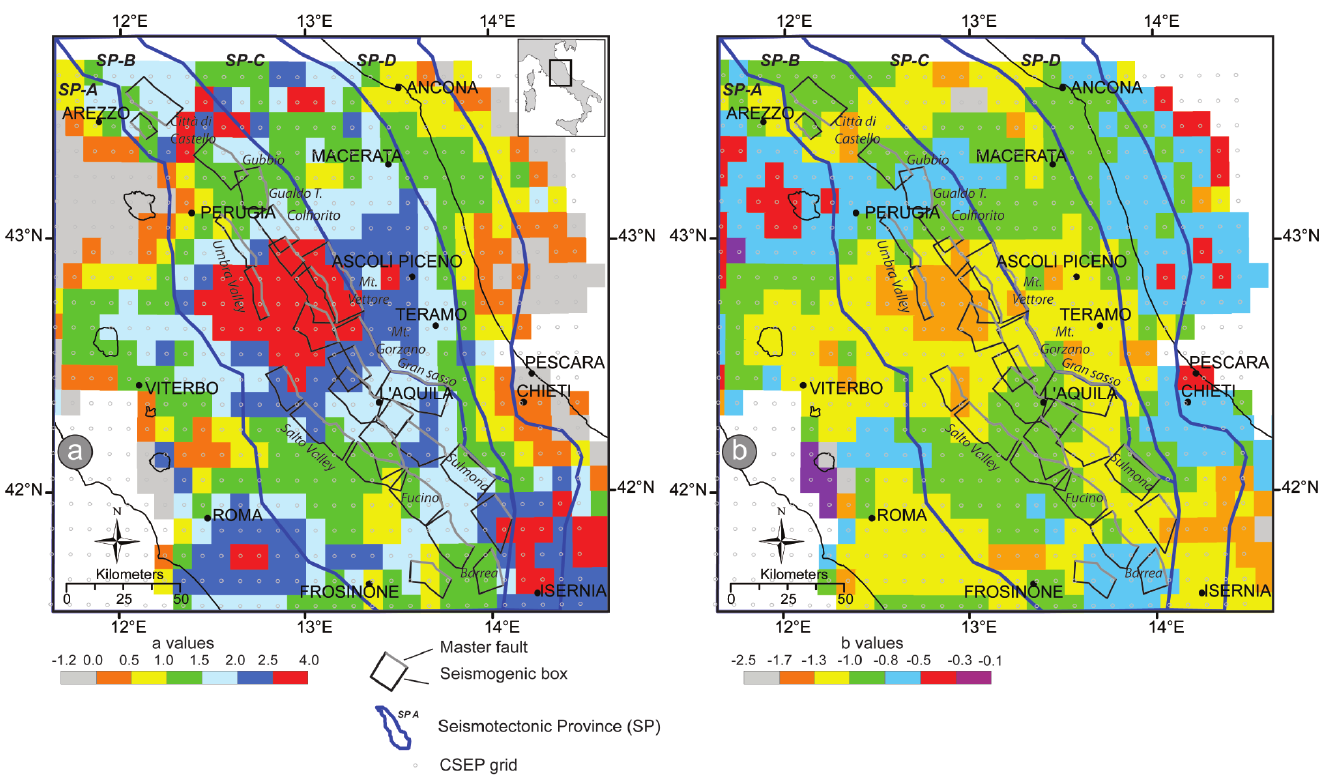
Figure 2. Maps of the Gutenberg-Richter coefficients computed using a grid node spacing of 0.1˚× 0.1˚ and a search radius of 20 km. The grid has the same spacing as in the original study in Pace et al. [2006], but it was shifted by 0.05˚ for the CSEP project. The dataset was the instrumental catalog from 1981 to 1996 (CSTI) [CSTI Working Group 2001]. The catalog was declustered following Knopoff [2000], to satisfy stationarity, and deep events (h > 50 km) and low magnitudes ( M < 2.0) were also filtered. The Gutenberg-Richter relationship was determined using the least-squares method. White nodes refer to subsets with too few events (n ≤ 5) to compute the G-R